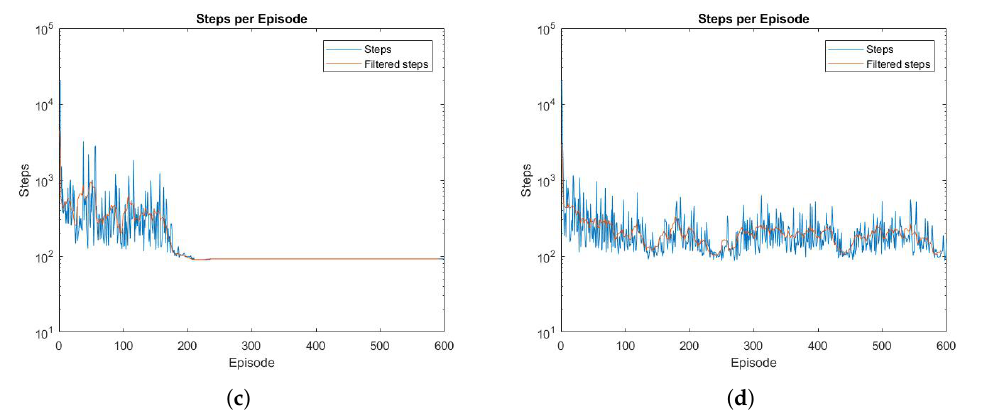
Figure 2. State-Action-Reward-State-Action (SARSA) graphs of the learning rates. In each episode ( x axis), the acrobot starts in the rest position. The acrobot lasts k steps ( y axis) to solve the swing-up problem. If the value of steps is lower on a higher episode, the algorithm is learning. ( a ) With no error and zero initialization; ( b ) With 5% error and zero initialization; ( c ) With no error and random initialization; ( d ) With 5% error and random initialization. Graphs ( a , c ) have no error in the measured values, while ( b , d ) have an added error of 5% of the range in all dimensions. ( a , b ) are initialized with zero values, but ( c , d ) are randomly initialized. The graph on the y axis is on a logarithmic